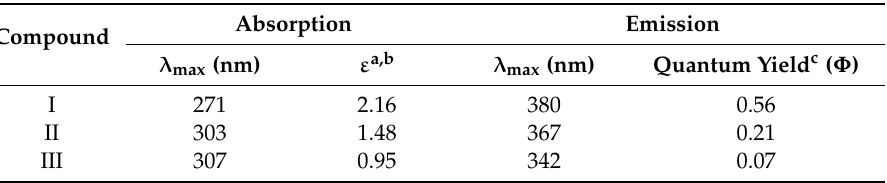
Table 1. Photophysical data of I, II and III.